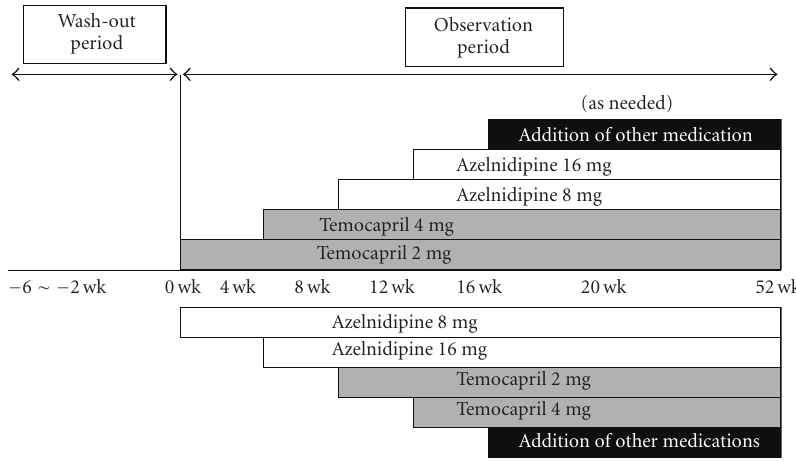
Figure 1: Study protocol; wk: